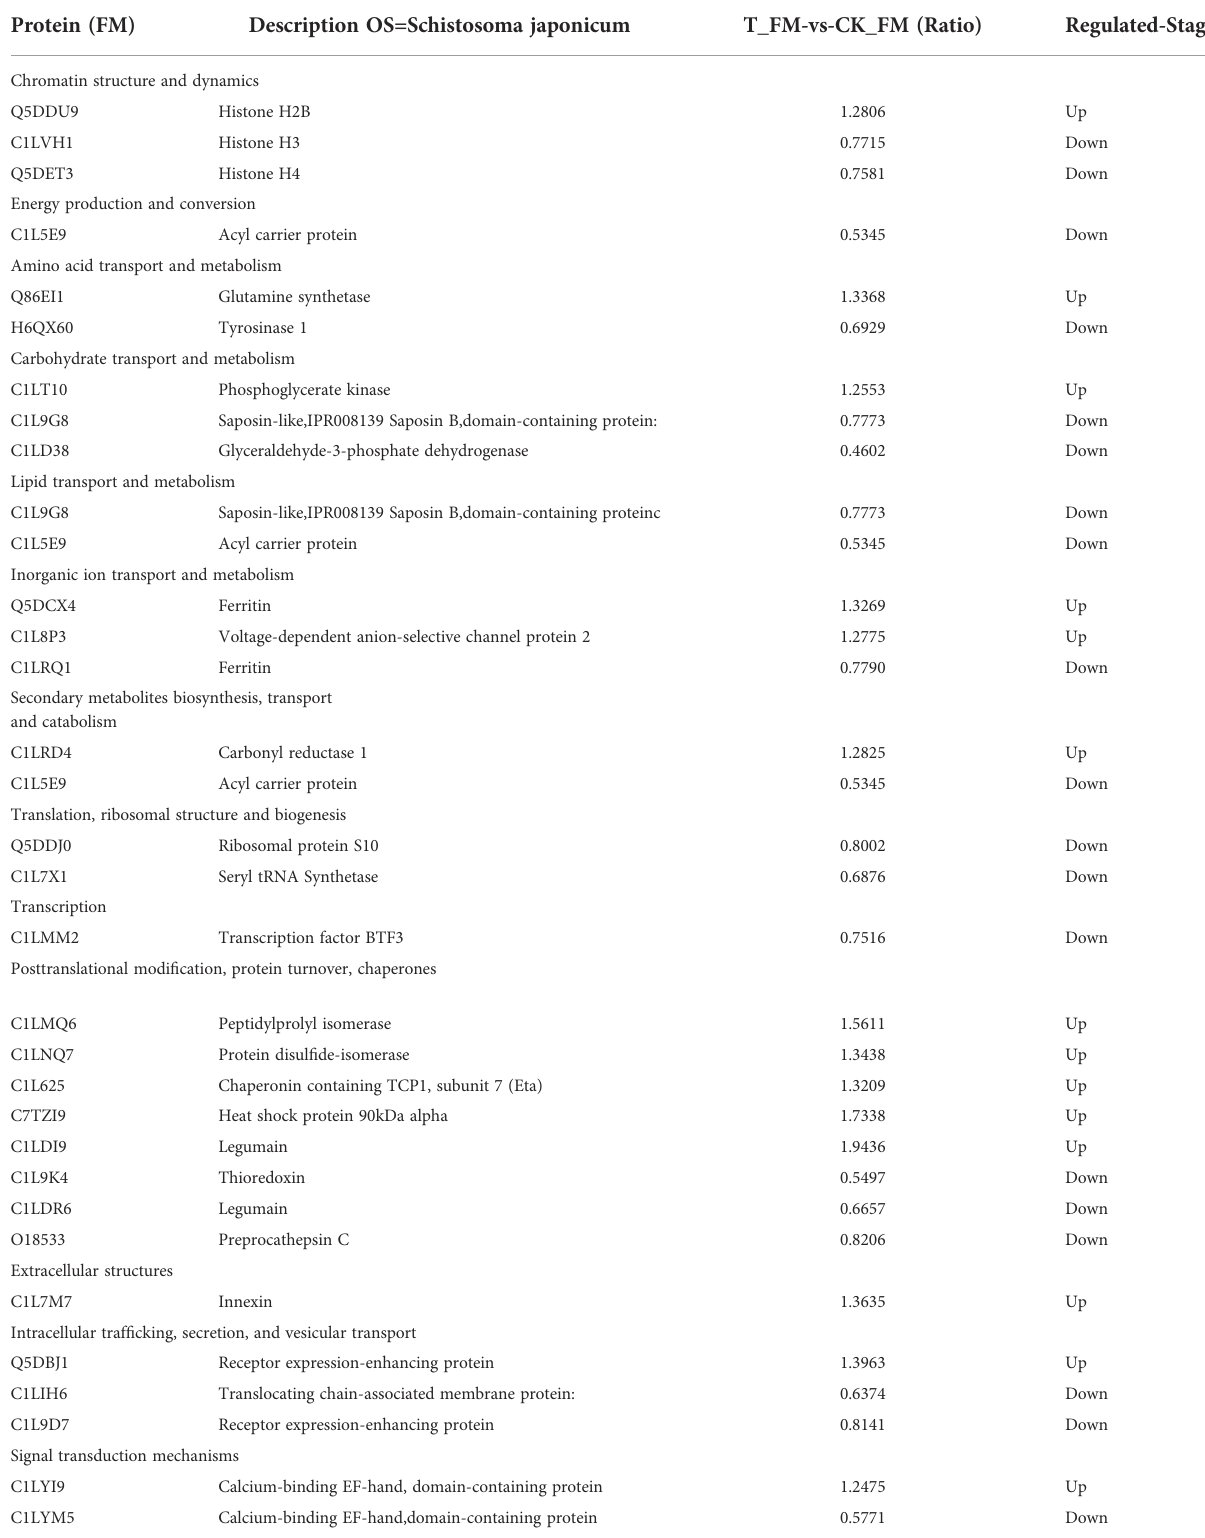
TABLE 1 Putative annotations of differentially expressed proteins (DEPs) of female S.japonicum